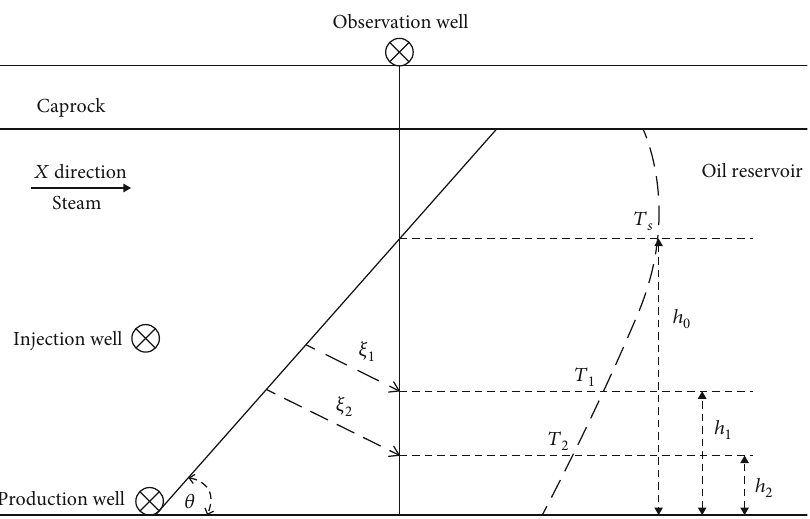
Figure 4: Schematic of the observation well temperature measurement